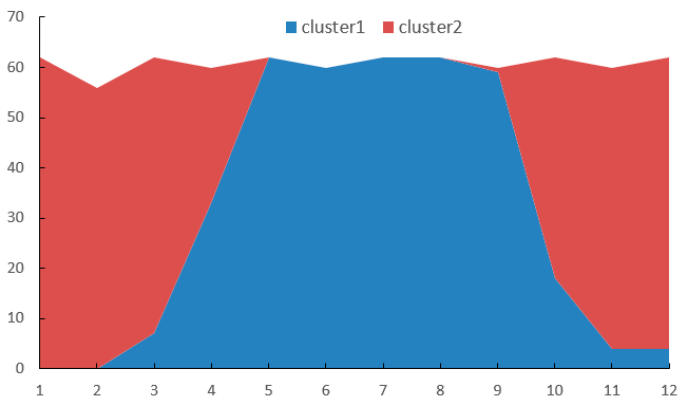
Figure 6. Month distribution of cluster 1 and cluster 2 (axis x for the months and axis y for the numbers of users).